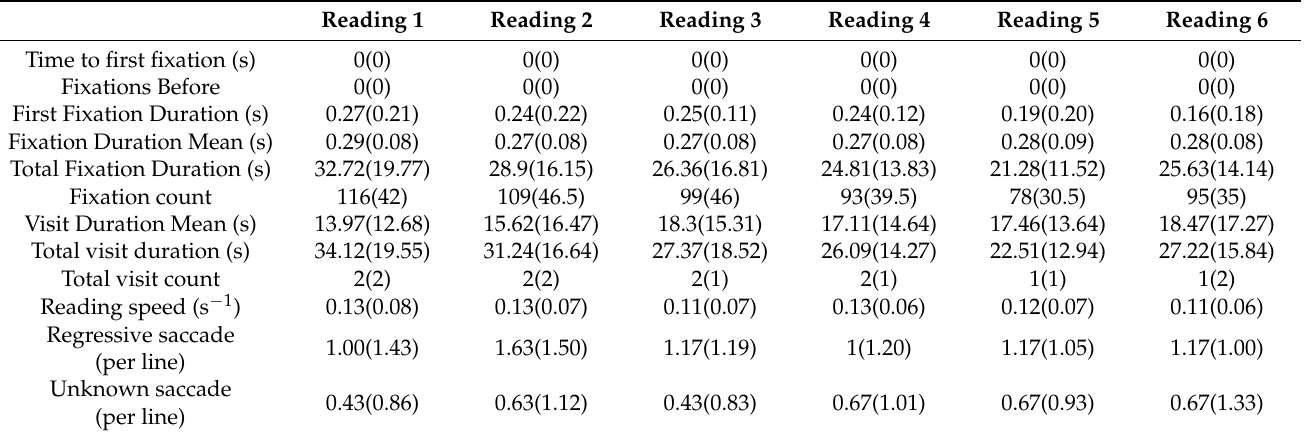
Table 4. Eye movement parameters in reading processes.